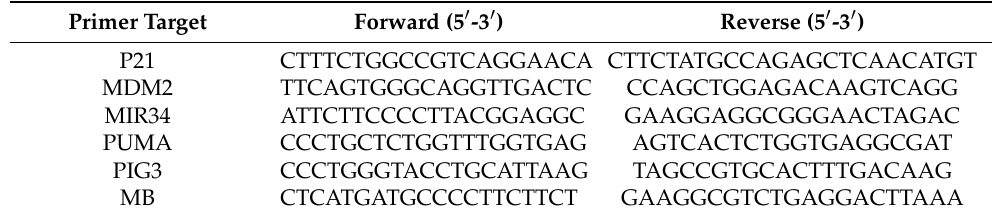
Table 1. Primer sequences for targeted ChIP.